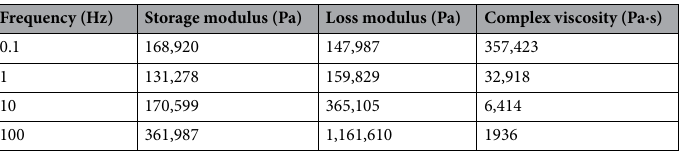
Table 1. Changes in storage modulus, loss modulus, and complex viscosity as a function of frequency.